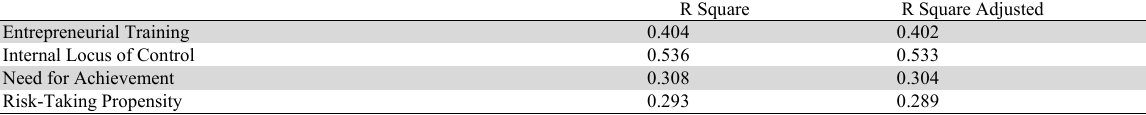
Evaluation of Quality Criterion and Predictive